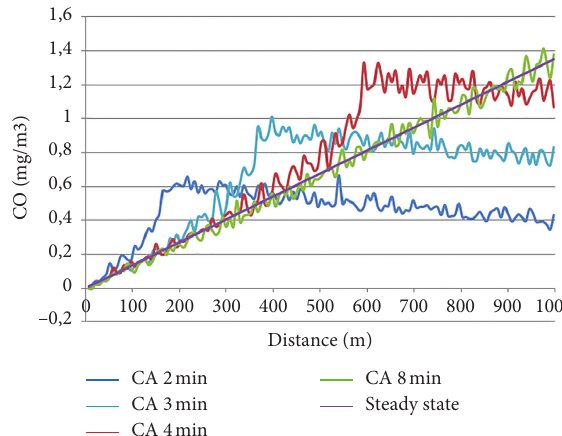
Figure 4: Comparison of models of CO